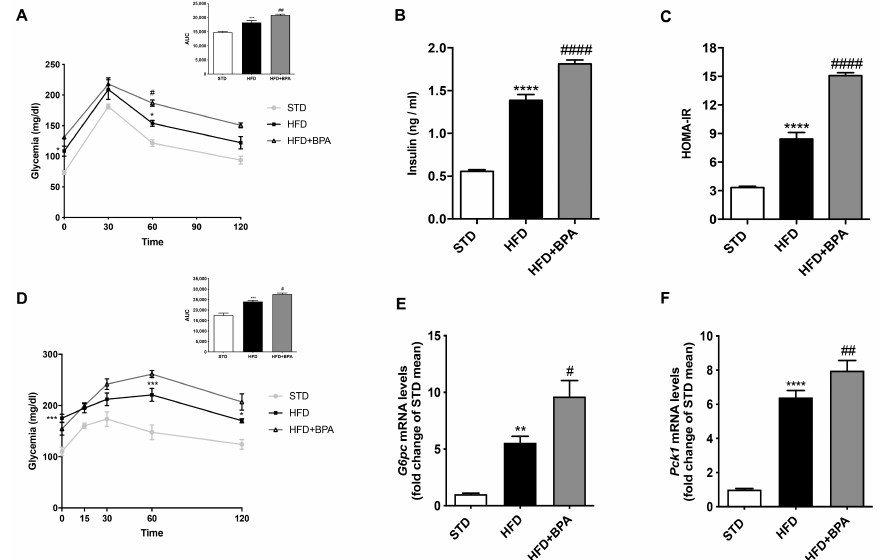
Figure 1. Bisphenol A (BPA) exacerbates glucose intolerance and gluconeogenesis already altered by high fat diet (HFD) feeding in mice. ( A ) Oral glucose tolerance test (OGTT) and ( D ) pyruvate tolerance test (PTT) were performed in all groups of animals ( n = 7 each group). ( B ) Insulinemia and ( C ) homeostasis model assessment insulin resistance (HOMA-IR) index were determined; gene expression of ( E ) G6pc and ( F ) Pck1 was measured in the liver of all animals by real-time PCR analysis. Data are presented as means ± SEM of all animals (n = 6 each group) (** p < 0.01, *** p < 0.001, and **** p < 0.0001 vs. STD; # p < 0.05, ## p < 0.01, and #### p < 0.0001 vs.